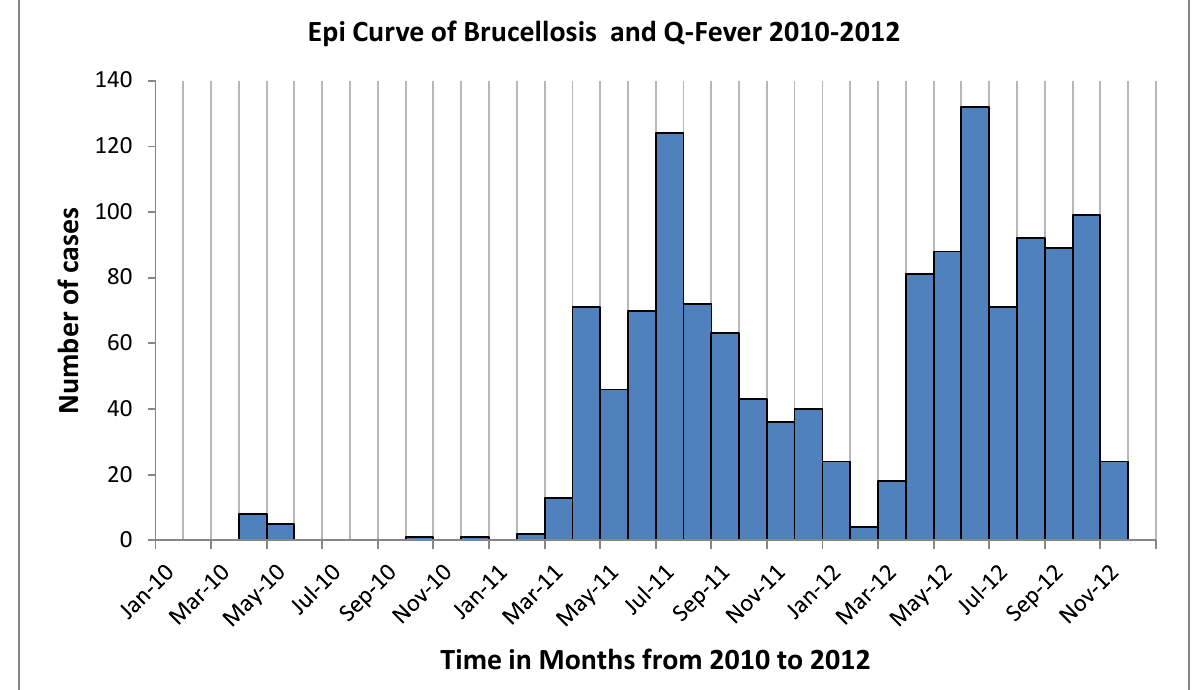
Figure 1: Epidemic curve of brucellosis and Q fever outbreak in Bamyan